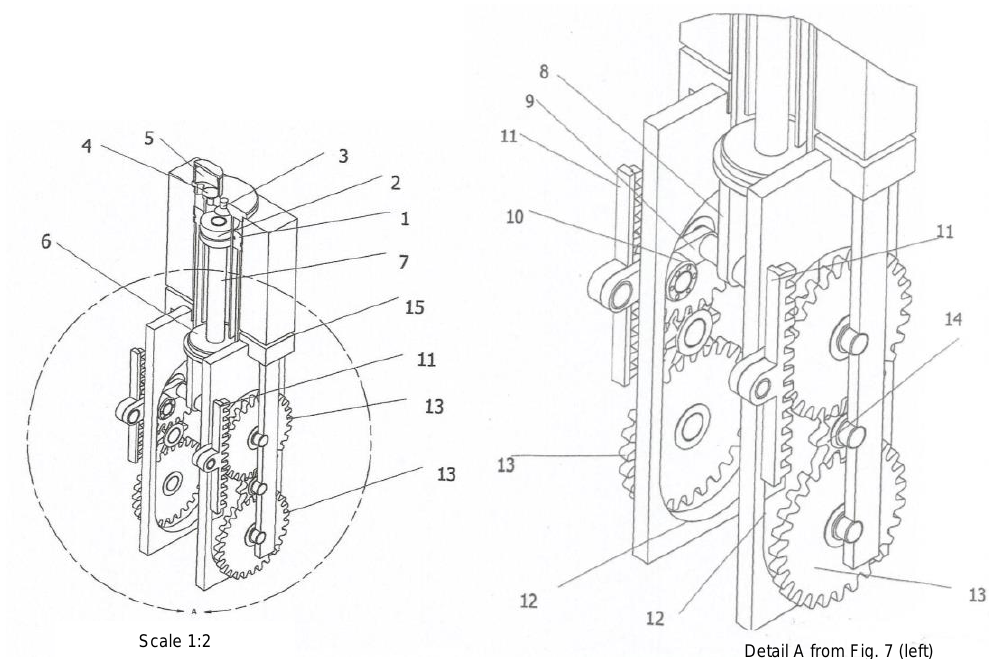
Detail A from Fig. 7 (left)